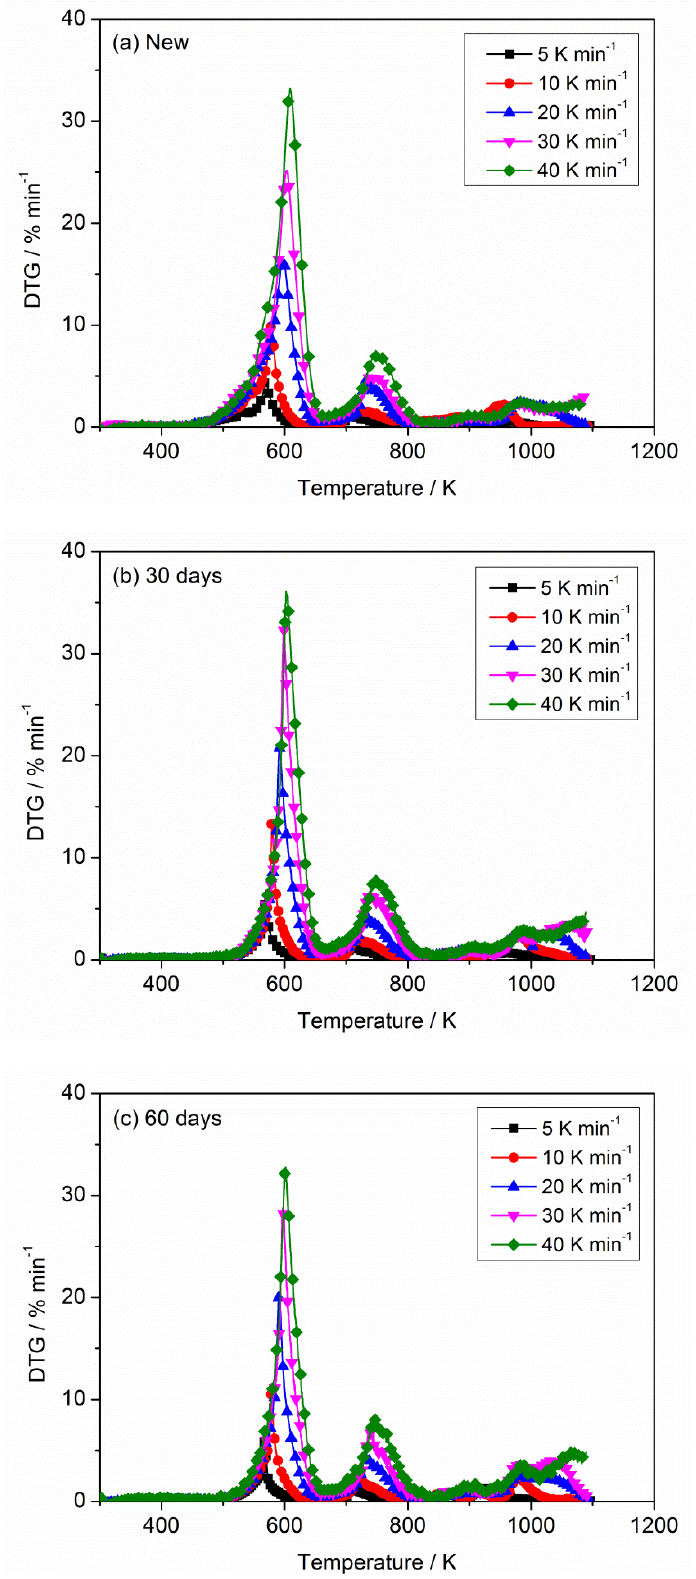
Figure 3. Mass loss rate (derivative thermogravimetric analysis (DTG)) curves of PVC sheath at different heating rates in nitrogen atmosphere: ( a ) new; ( b ) aged 30 days and ( c ) aged 60 days.